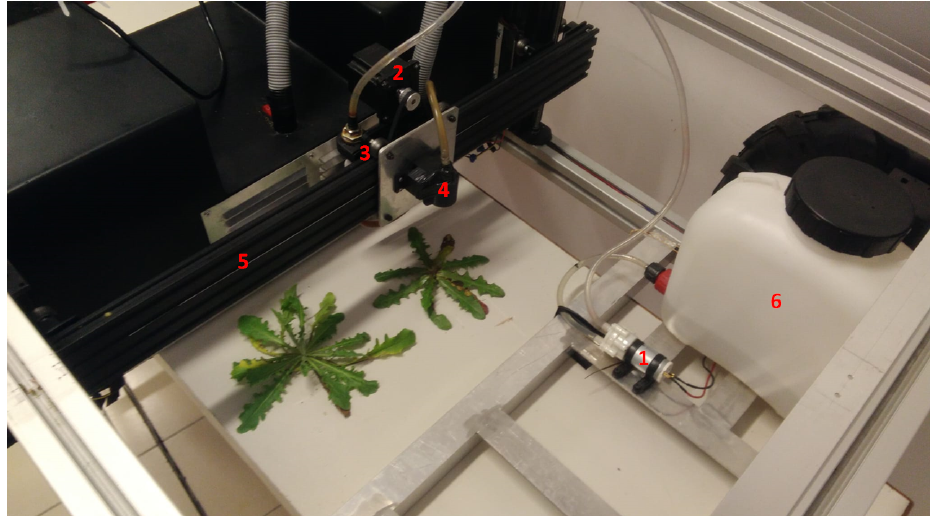
Figure 6. Main components of the robotic rover for weed control. (1) pressure motor: The DC motor that applies pressure to the herbicide container; (2) manipulator motor: The stepper motor that moves the axis of the Cartesian manipulator; (3) nozzle relay: The relay that opens and closes the spray valve; (4) spray nozzle; (5) Cartesian robot manipulator; (6) herbicide container.